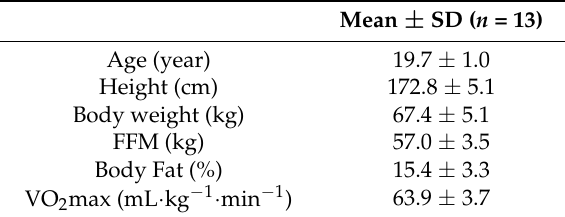
Table 1. Initial characteristics of the